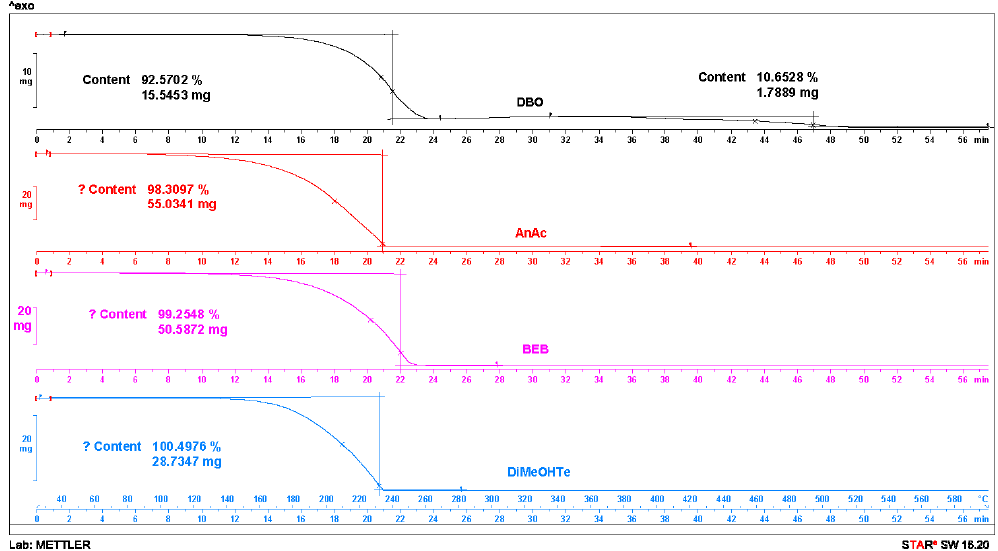
Figure A6. TGA data of DBO, AnAc, BEB and